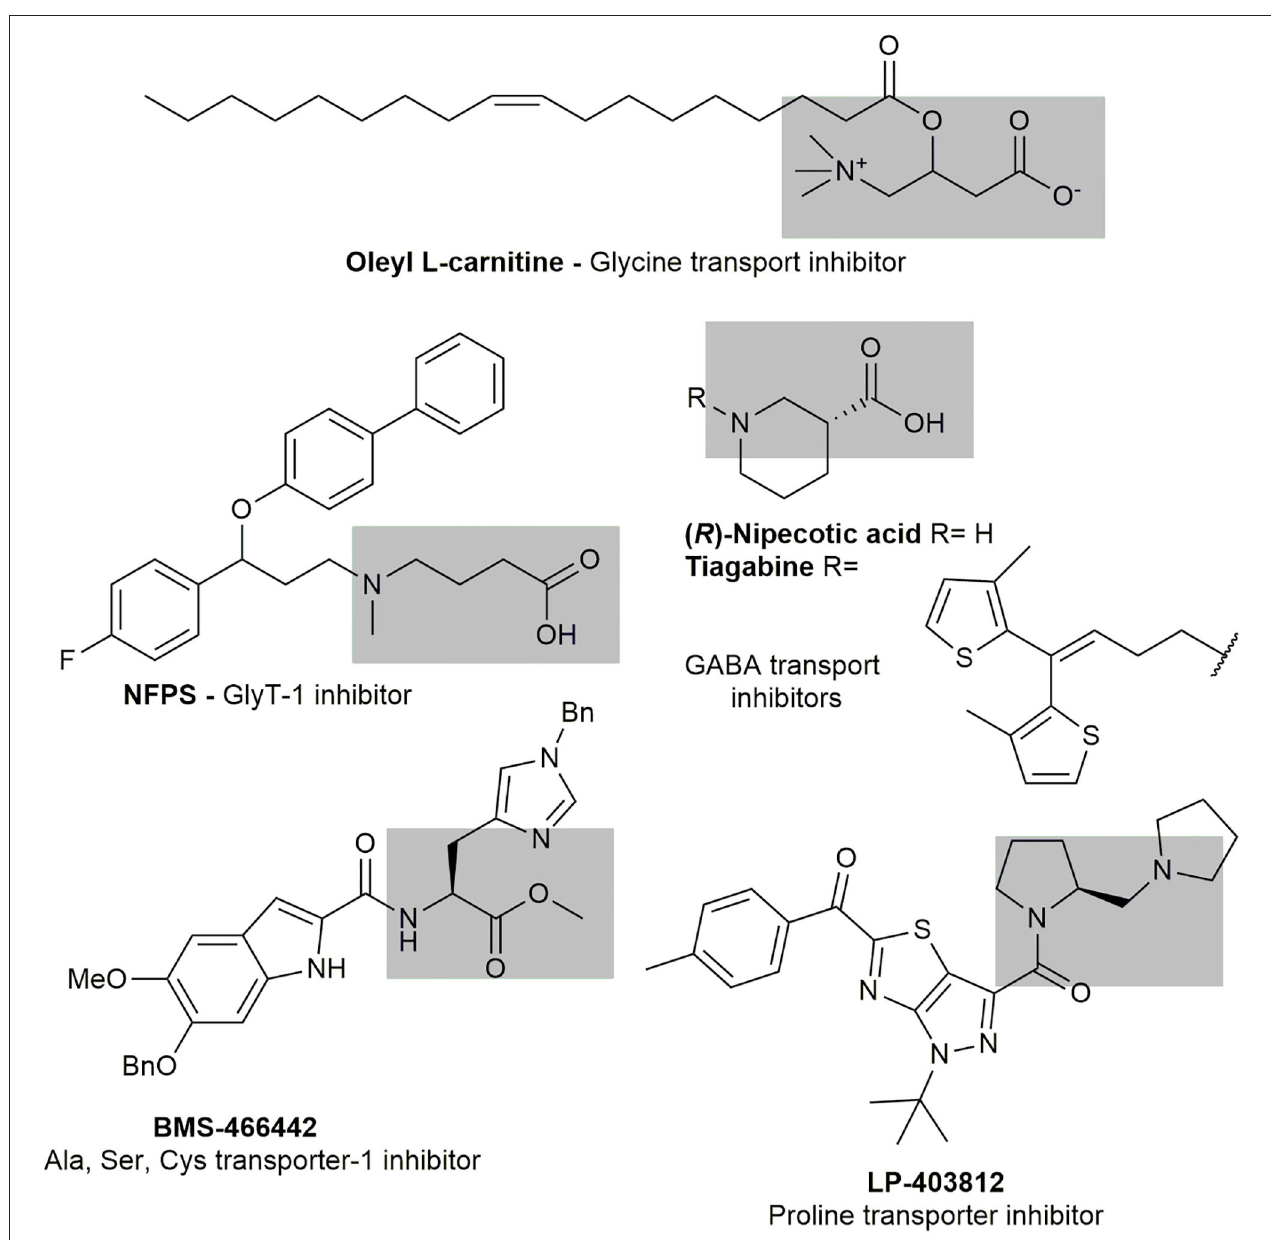
FIGURE 5 | Known amino acid transport